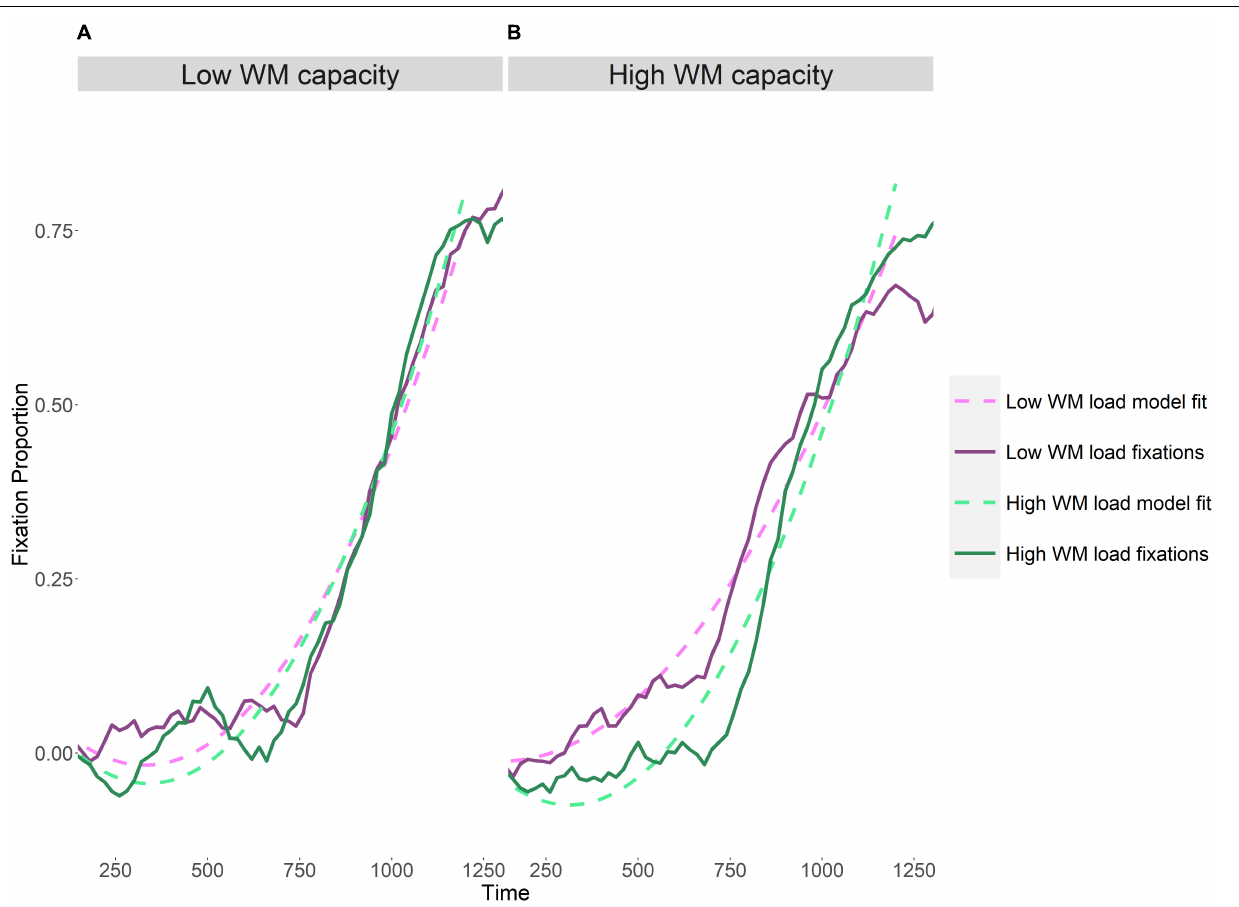
FIGURE 2 | Time-course of target discrimination scores . Fixations are shown as a subtraction, with phonological competitor fixations subtracted from the target fixations. The model fits (dashed lines) are plotted along with the observed fixation data (solid lines). Left panel (A) show the proportion of fixations for each load condition, one and four digits, respectively, for the low WM capacity group and panel (B) show the high WM capacity group. TABLE 4 | Results of growth curve analysis (GCA) – onset overlap.